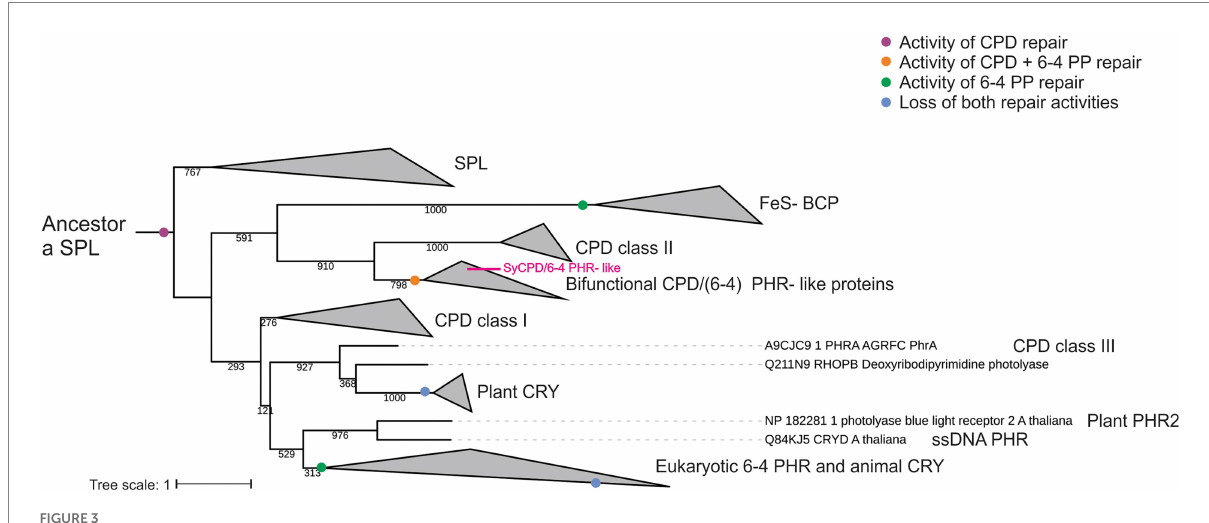
FIGURE 3 Phylogenetic distribution of the cryptochrome/photolyase family including bifunctional CPD/(6-4) PHR- like proteins. Phylogenetic tree with a CPD photolyase with an iron–sulfur cluster (SPL) as the first common ancestor. Proposed major evolutionary events regarding DNA damage repair activity are indicated by colored dots. Maximum-likelihood probabilities of 1,000 replicates are adjacent to each internal node. Branches corresponding to proteins from the same clade were collapsed. Complete phylogeny is shown in Supplementary Figure